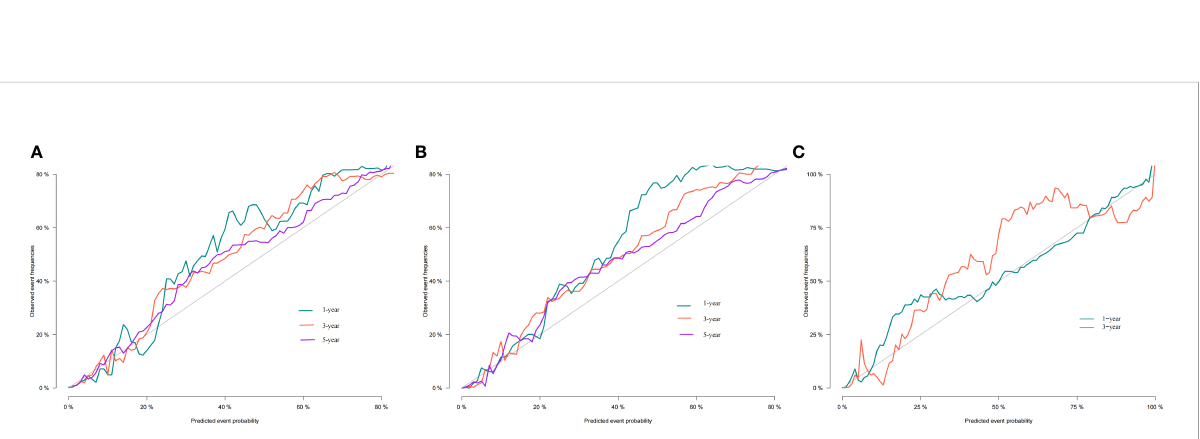
FIGURE 6 Calibration curves of nomogram. (A) For 1-, 3-, and 5-year CSS in training cohort; (B) For 1-, 3-, and 5-year CSS in validation cohort; (C) For 1-, 3-year CSS in external validation cohort.